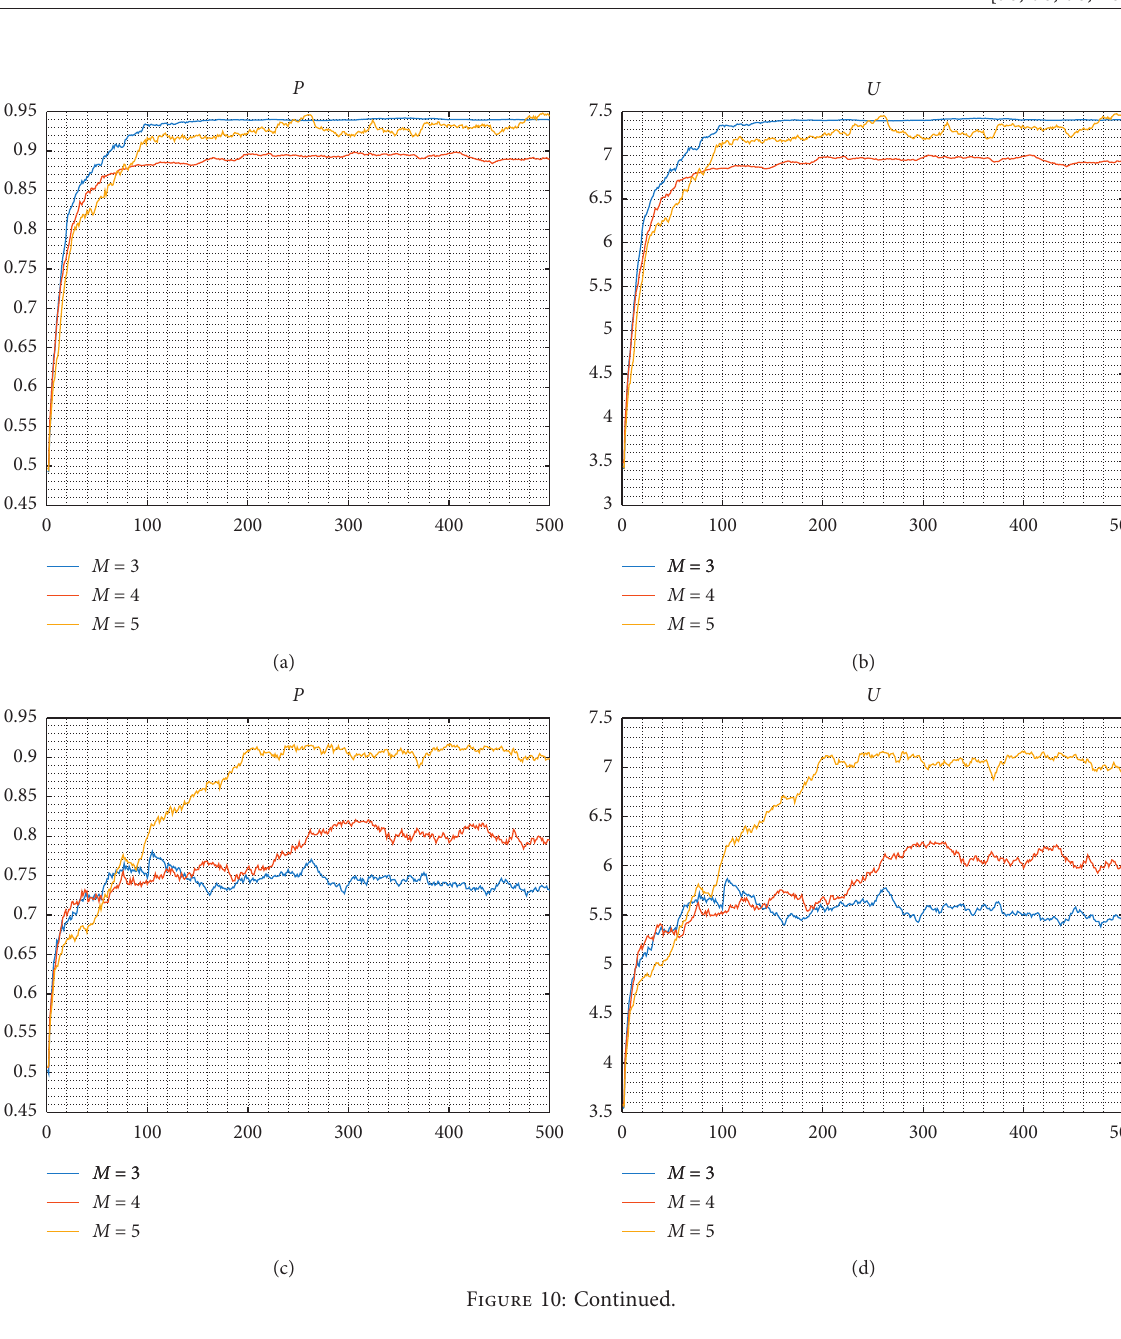
Experiment 3: comparison between uniform network and nonuniform